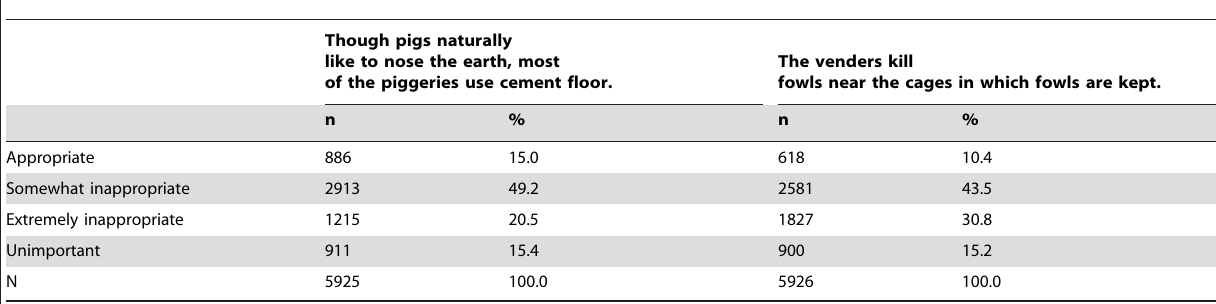
Table 3. China’s Public Attitudes to the Way of Treating Pigs and Domestic Fowls in their Daily Life.